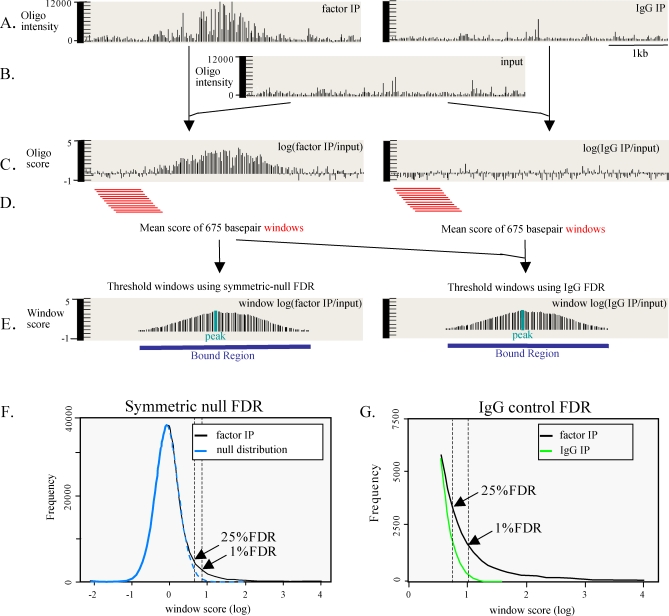
Overview of ChIP/chip Data Analysis Methods(A–C) Mean hybridization intensities (A) for Factor IP replicates (left) and IgG control IP replicates (IgG) (right) are divided by the mean probe intensity in the input DNA samples (B) to produce oligonucleotide ratio values (C).(D–G) The logarithms of the ratios in (C) are averaged in windows (D) of 675 bp centered around each probe (after discarding the highest and lowest values, to produce a “trimmed mean”) to produce window scores (E). Bound regions (E) were identified by comparing window scores to expected score distributions computed from a symmetric null distribution (F) or from IgG controls (G). The symmetric null method assumes that the background window score distribution is symmetric about its mean, and estimates the distribution from values less than the observed mode ([F] light-blue line). This estimated null distribution was used to assign p-values to each window score, and these were corrected for multiple testing to control the FDR, using the method of ([95] and http://faculty.washington.edu/∼jstorey/qvalue/). The IgG control is similar except that the empirical distribution of window scores from the IgG immunoprecipitations ([G] light-green line) is used as the estimated null distribution.